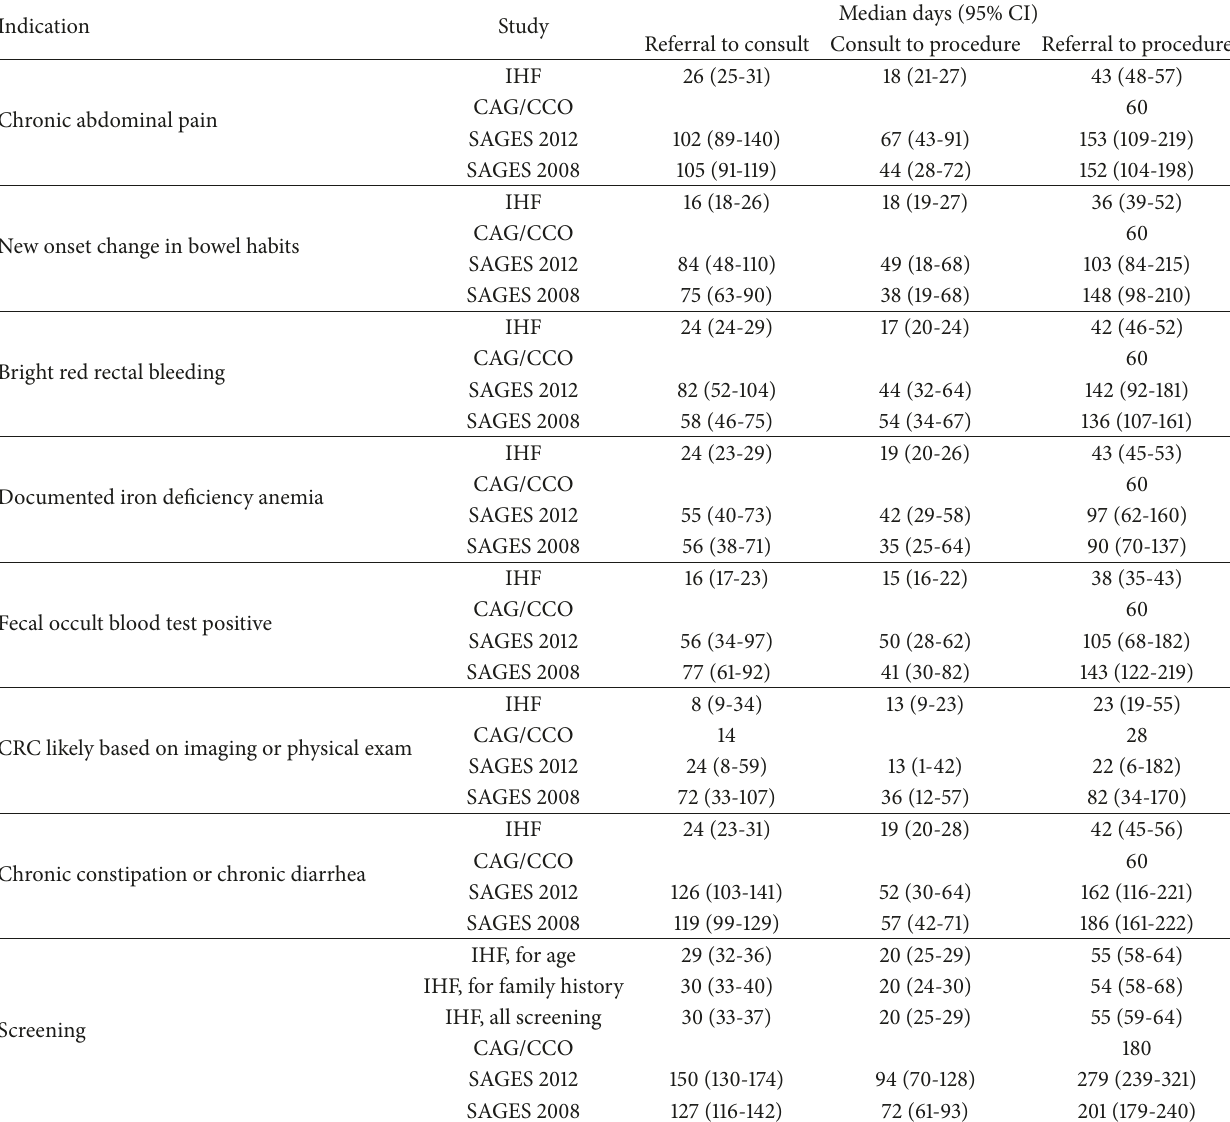
Table 2: Overall wait time indications for colonoscopy for this IHF, the SAGES 2008 survey, and the SAGES 2012 survey, and recommendations of Canadian Association of Gastroenterology and Cancer Care Ontario [3, 6, 7].